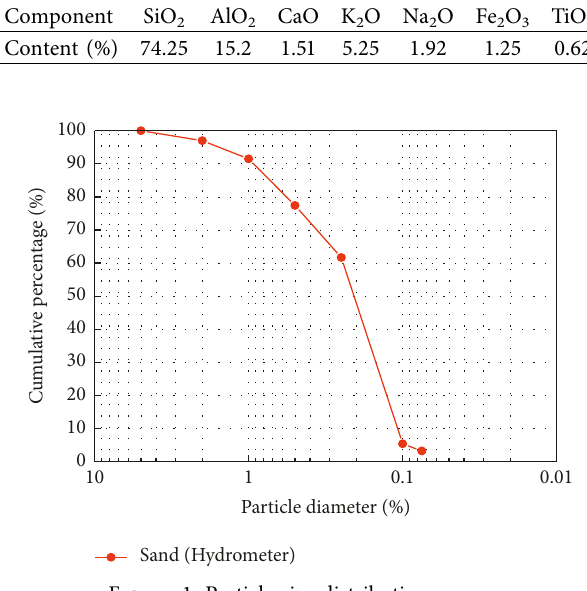
Figure 1: Particle size distribution